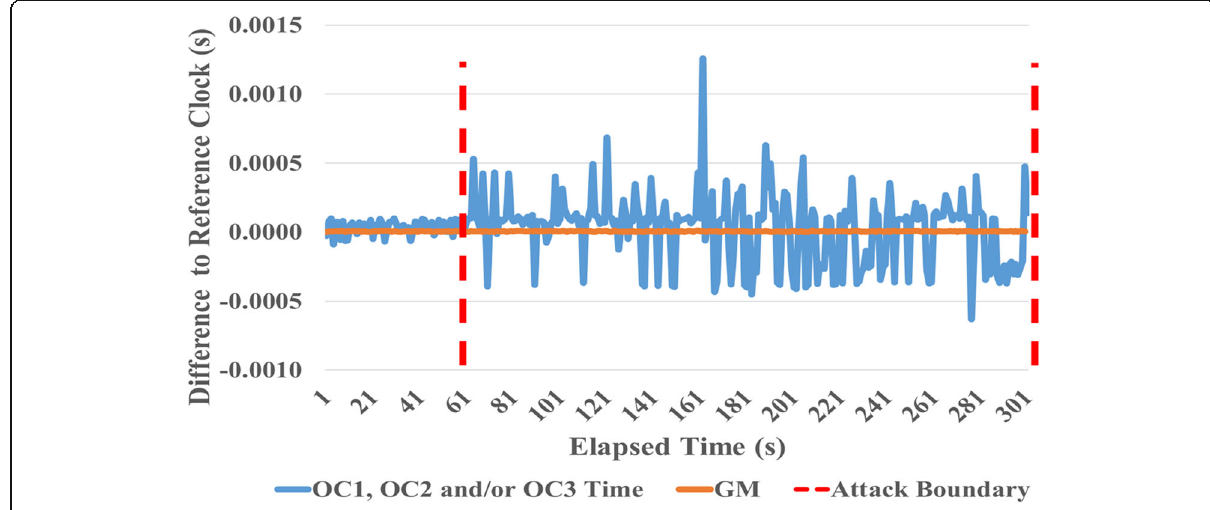
Fig. 8 Impact of DoS attack/packet removal